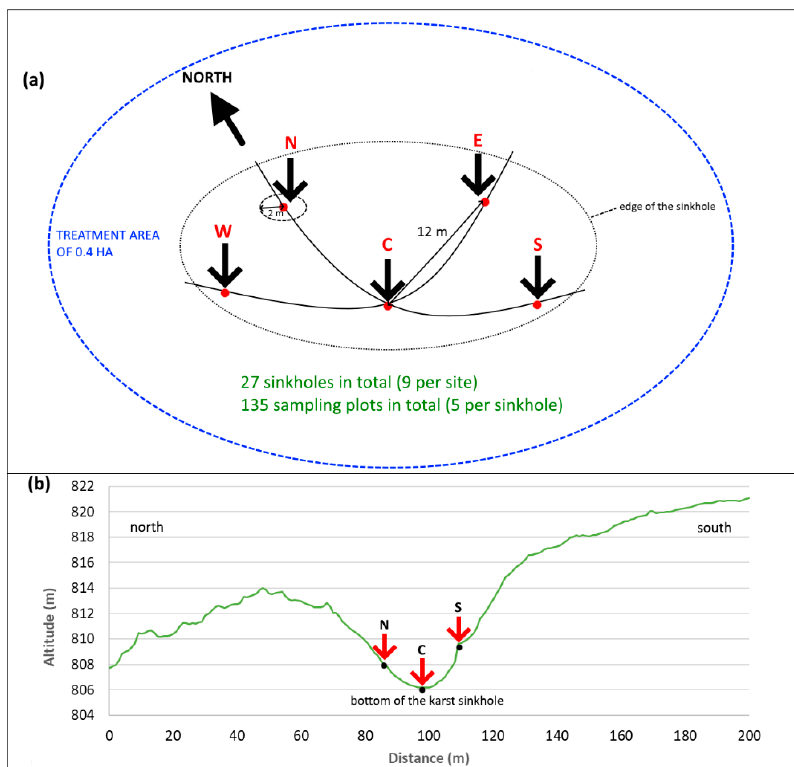
Figure 1. ( a ) Simplified illustration of a karst sinkhole with five sampling plots (C—centre, N—north, E—east, S—south, W—west). ( b ) Vertical profile (the green line represents the terrain’s surface) from north to south for one of our study sinkholes. Data were derived from LiDAR.